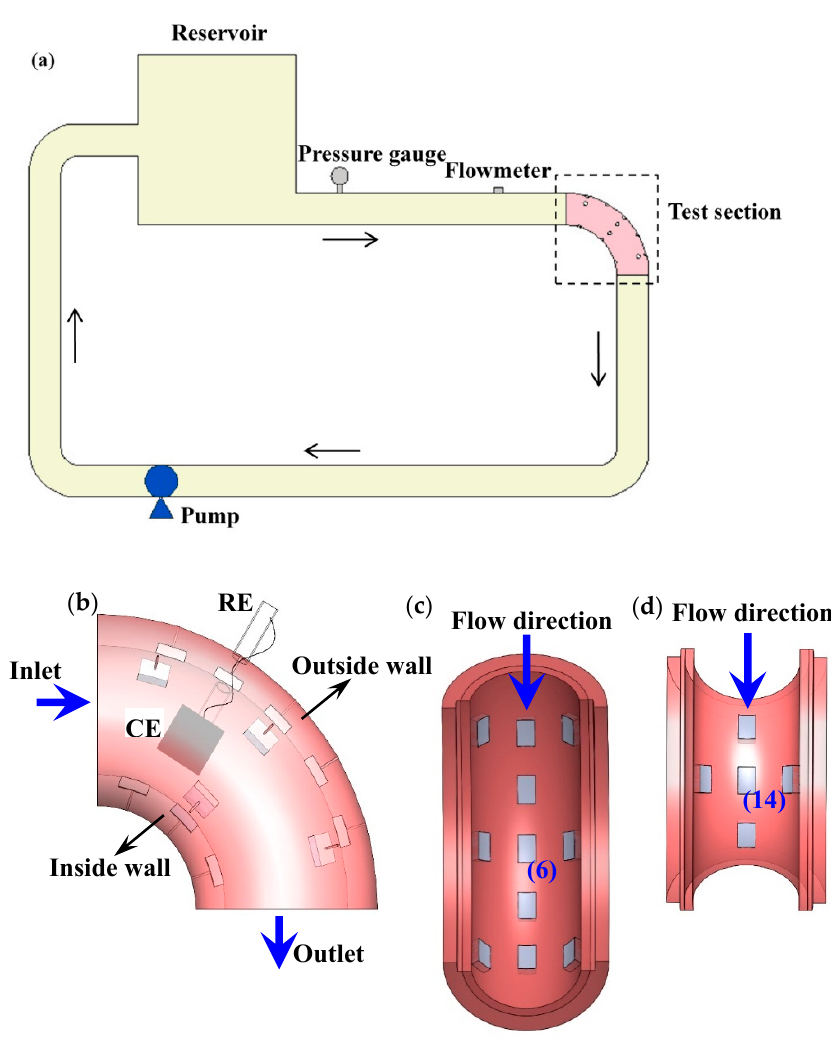
Figure 1. Schematic diagrams of the loop apparatus and bend testing zone for flowing tests: ( a ) loop apparatus; ( b ) bend testing zone; ( c ) array electrodes distribution at the outside wall; ( d ) array electrodes distribution at the inside wall.